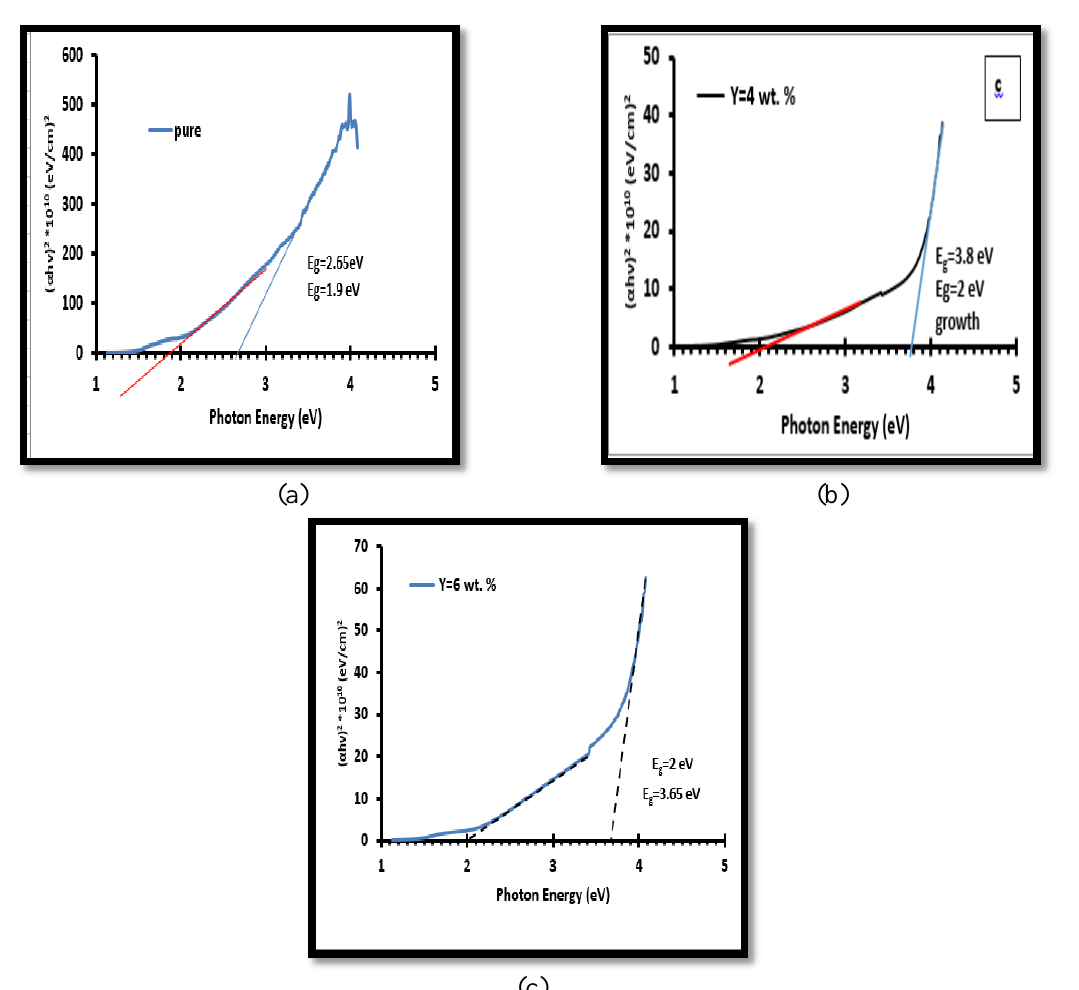
Fig.3: Tauc plot of (a) pure Co with 6 % yttrim. Table 3: Energy gap estimated from Tauc relation of pure and doped Co